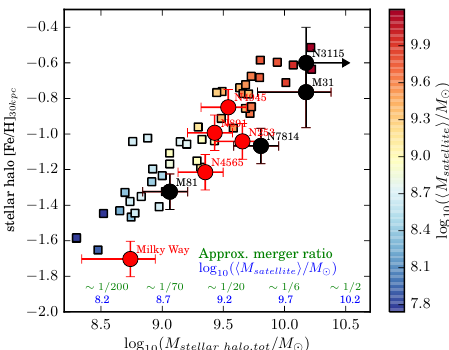
Figure 3. Circles show the observed correlation between stellar halo mass and metallicity. Galaxies with “classical” bulges are shown in black, galaxies with “pseudobulges” are shown in red. Squares show simulated stellar halo masses and metallicities from the accretion-only models of Deason et al. [23]. The squares are color-coded according to the mass weighted mean stellar mass of the contributing satellites to the halo; we indicate the approximate run of mass weighted mean accreted satellite mass in blue and corresponding approximate merger ratios for a main galaxy mass at the time of merger of 3 10 10 M in green. Adapted from Figure 1 of [9], reproduced with permission of the American ∼ × (cid:12) Astronomical Society